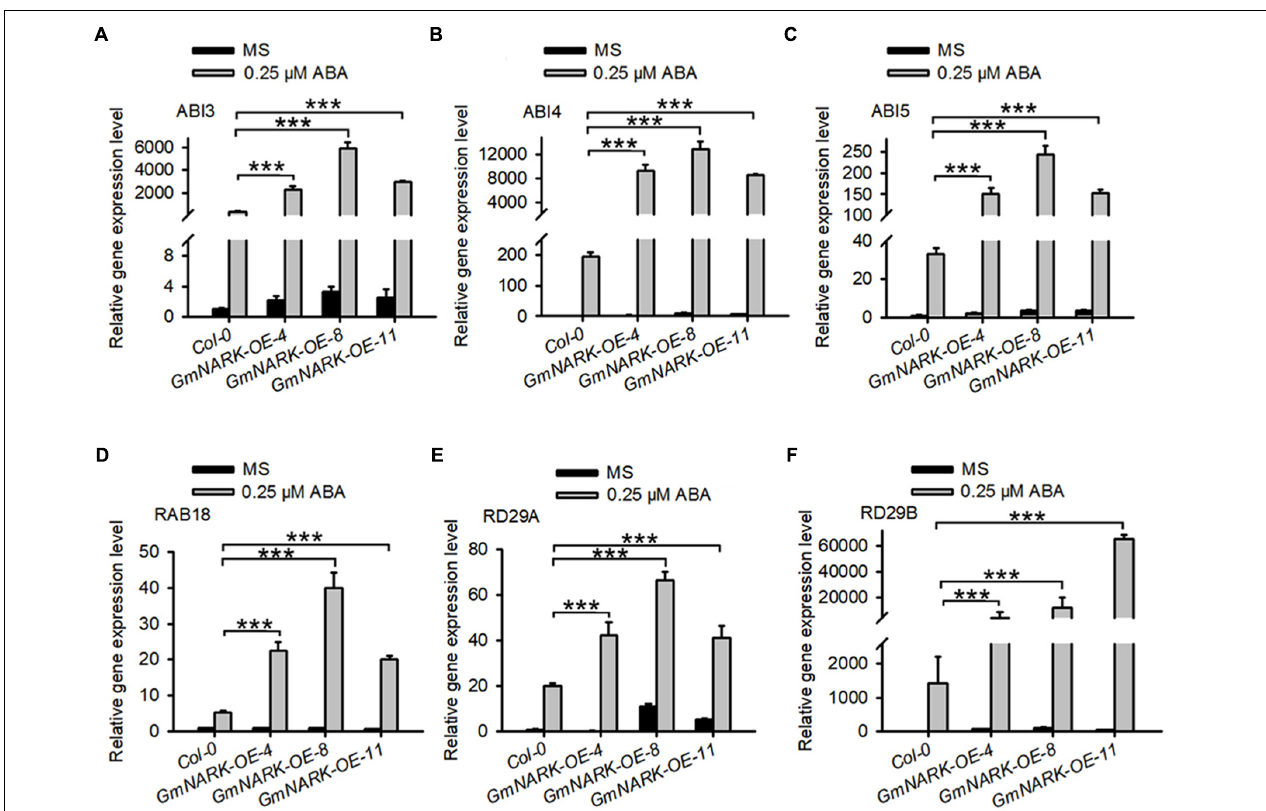
FIGURE 9 | Expression analysis of abiotic stress related genes in the wild type and transgenic plants overexpressing GmNARK . The relative transcript level of (A) ABI3 , (B) ABI4 , (C) ABI5 , (D) RAB18 , (E) RD29A , and (F) RD29B in Col-0 , GmNARK-OE-4 , GmNARK-OE-8, and GmNARK-OE-11 plants were analyzed. Seedlings were grown on MS medium with or without 0.25 µ M ABA for 7 days. Three independent experiments were performed with similar results, each with three replicates. ACTIN2 was used as the internal control. The student’s t -test was performed and the statically significant treatments were marked with ‘ ∗∗∗ ’ ( P <